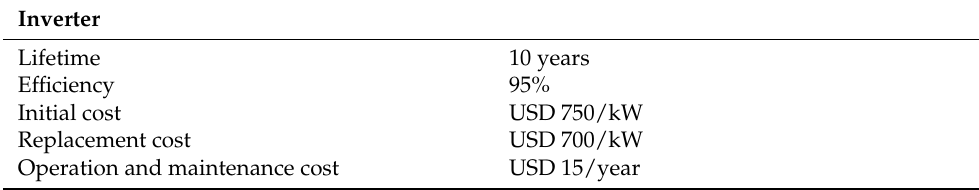
Table 4. Inverter